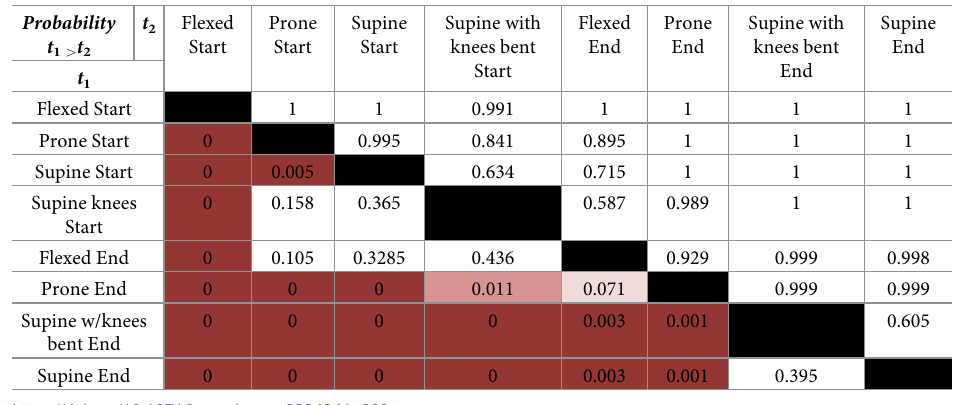
Table 3. Results of Oxcal “Order” function test for burial position start and end boundaries, showing probability that t 1 (y axis) start and end boundary event preceded t 2 (x axis) start and end boundary event, based on posterior model results. Results are shaded in red according to significance, with the deepest red indicating lowest